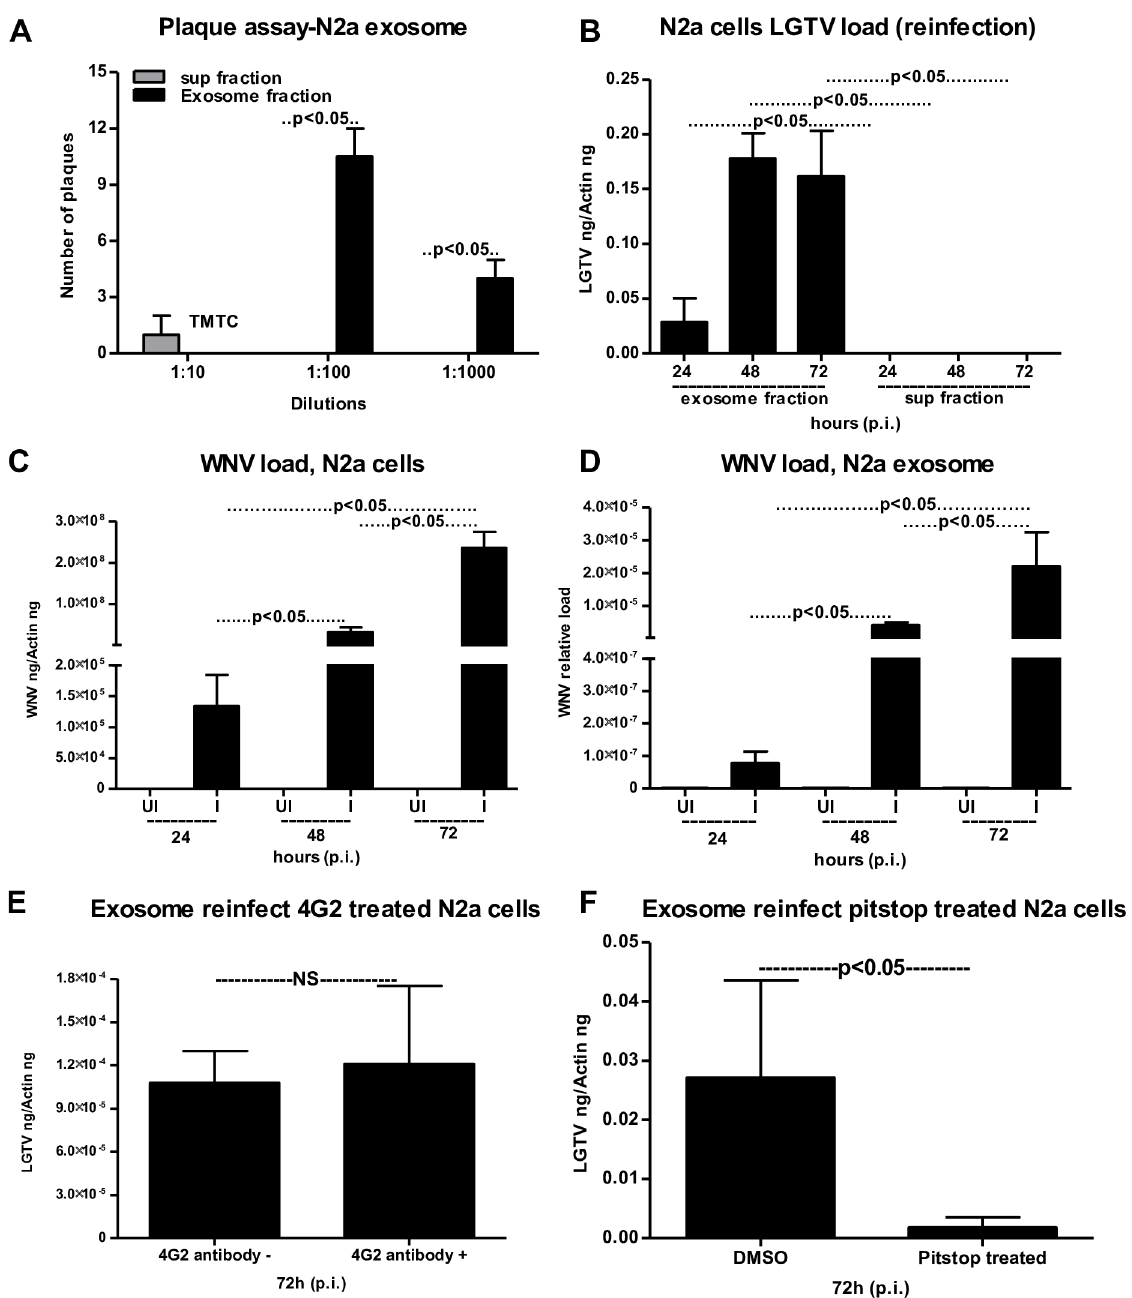
Fig 4. Transmission of LGTV through infectious exosome to na ï vecells is clathrin dependent. (A) Quantitative assessment of number of plaquesfrom exosomal and supernatantfractions is shown. TMTC indicates“too many to count”. (B) QRT-PCR analysisfor the LGTV loads in fresh N2a (1 x 10 5 ) cells at 24 h p.i., infected with exosomes(20 μ l) or supernatant (400 μ l) fractions preparedfrom 24, 48 and 72 h p.i. (C) Mouse N2a cells showinginfectionkinetics with WNV (MOI 5) at different times (24, 48, 72 h) p.i., WNV E genetranscript levels were normalized to mouse beta-actin. (D) Relativeloads of WNV in infected N2a cell- derivedexosomes collectedat 24, 48, 72 h p.i. LGTV loads (72 h p.i.) in N2a cells treated with either 4G2 antibody (5 μ g for 4 h) (E) or Pitstop-2 clathrin inhibitor(F) (treated 30 μ M for 15 min at 37˚C) and infected with LGTV-containing (72 h p.i.) N2a cell-derived exosomes is shown. Infected but untreatedsamples serve as control in (E). Infected but DMSO-treated serve as control in (F). LGTV transcript levels were normalized to mouse beta-actin. P value determined by Student’s two-tail t test is shown. Representative data is shown from at least three